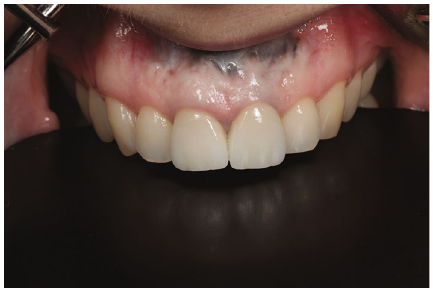
Figure 29: Clinical view after cementing the de fi nitive crowns.